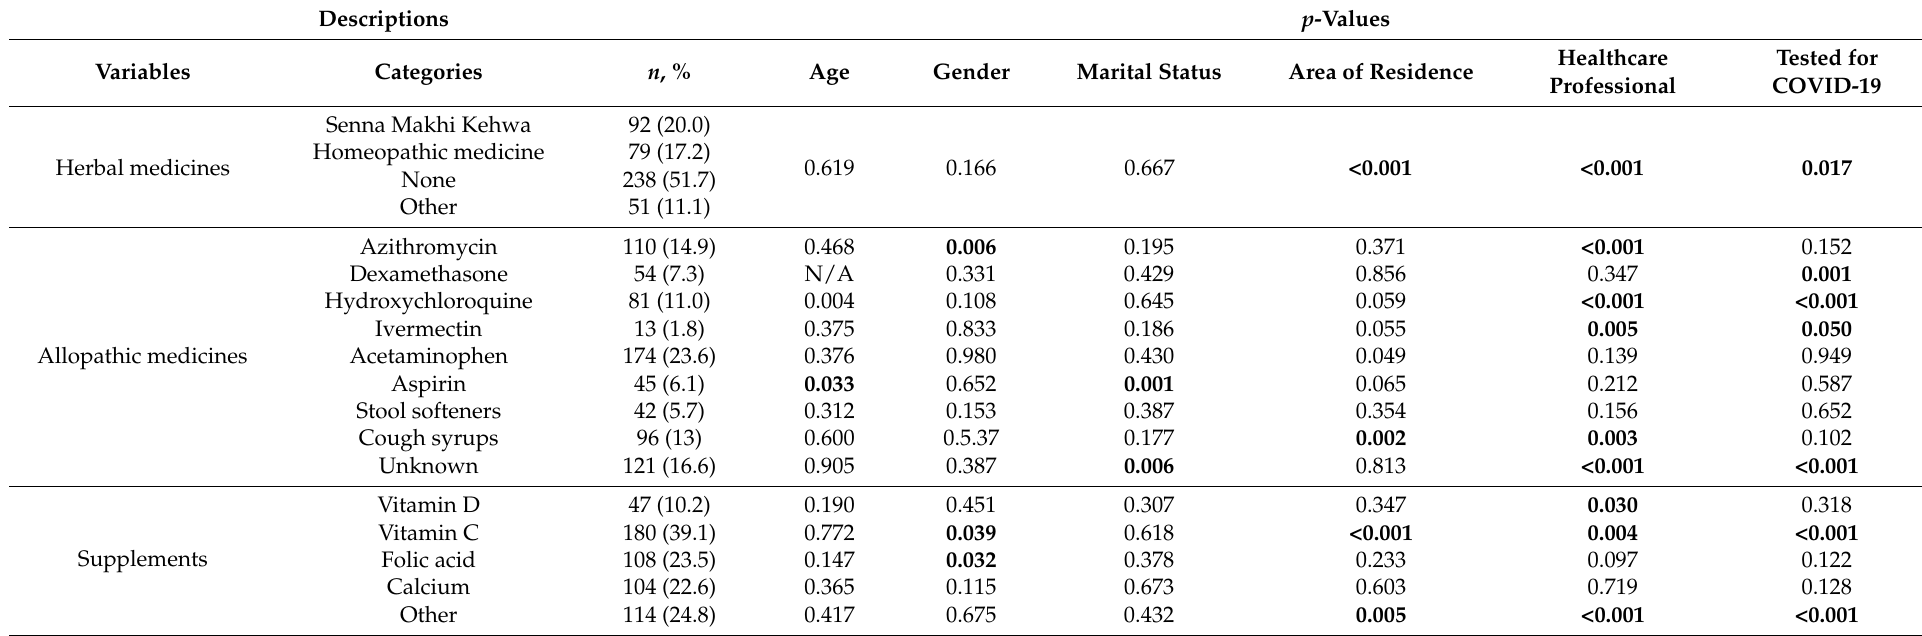
Table 3. Medicines used as SM during the COVID-19